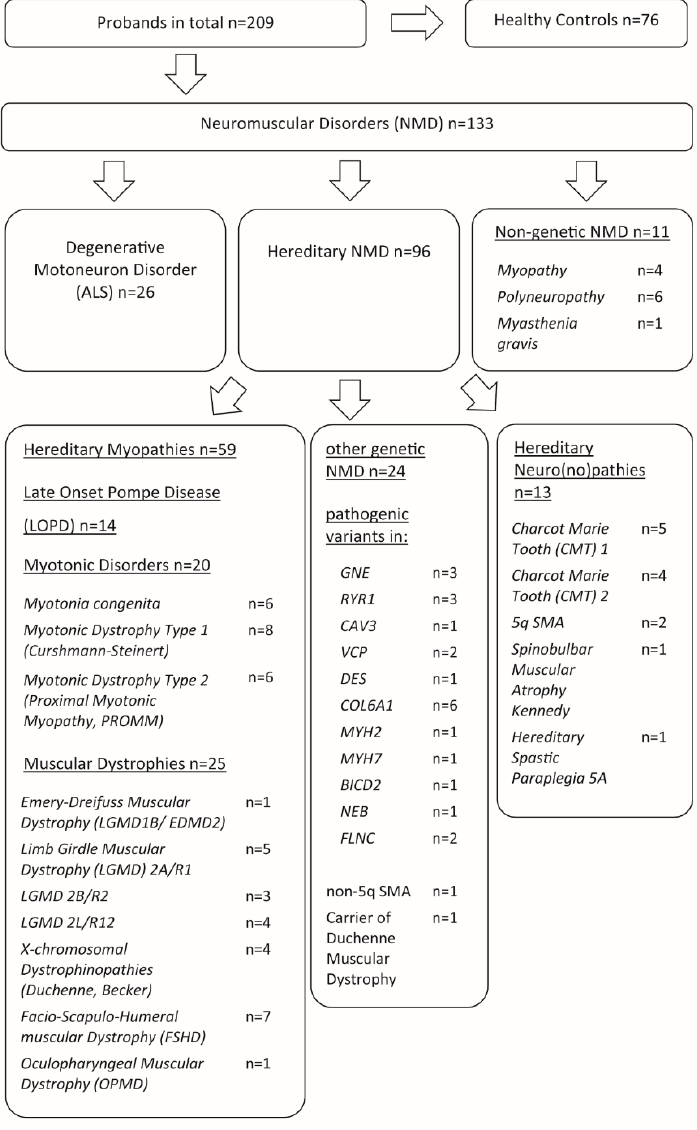
Figure 1. Serum donor cohort. Sera were collected from 209 patients, 133 of the serum donors were patients with NMD, and 76 were healthy controls without NMD. Patients with NMD comprised patients with degenerative motoneuron disorder, non-genetic NMD and hereditary NMD, including hereditary myopathies, hereditary neuro(no)pathies and other genetic NMD.